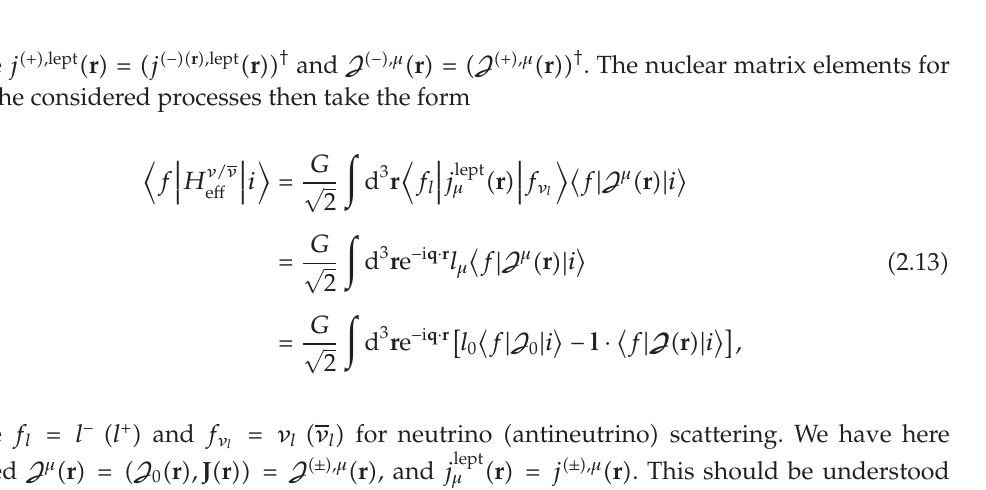
− k (cid:7) p − p (cid:6) μ μ μ μ